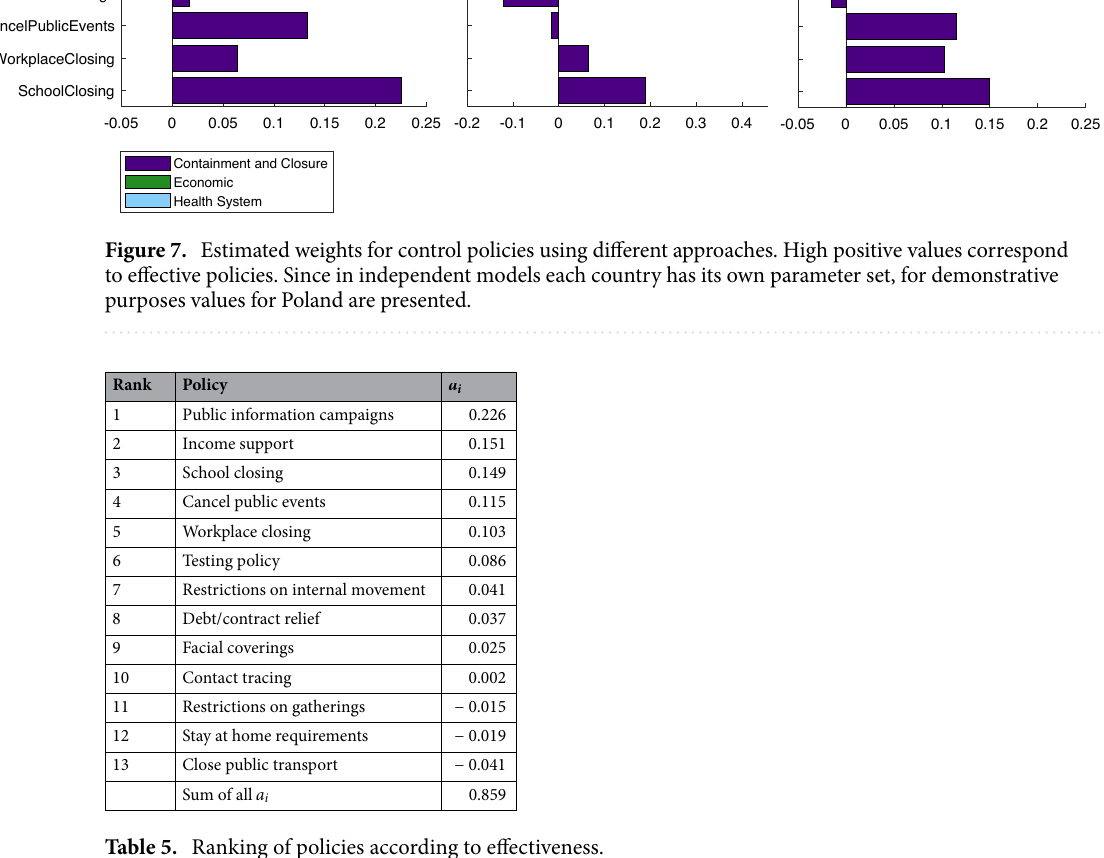
Table 5. Ranking of policies according to effectiveness.